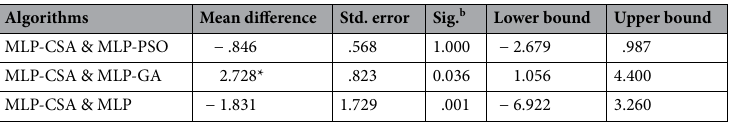
Table 8. Pairwise comparisons of all algorithms prediction error for the UPF efficiency. *The mean difference is significant at the .05 level. b Adjustment for multiple comparisons: Bonferroni.